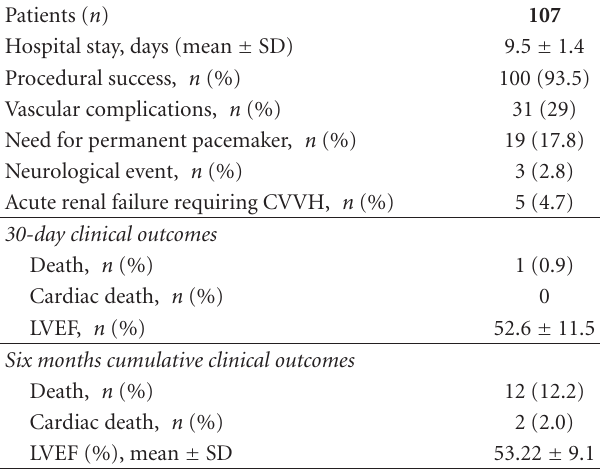
Table 2: Procedural and in-hospital results of patients submitted to transfemoral TAVI approach in our